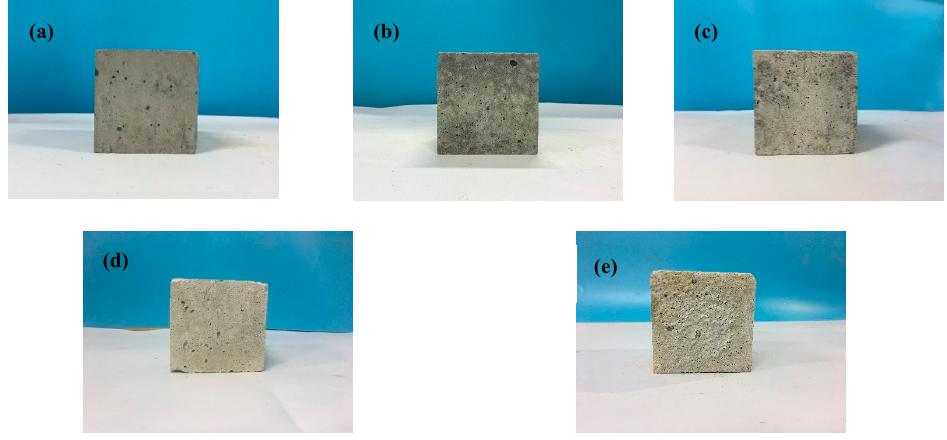
Figure 2. Appearance of C30 specimen at different sulfuration ages: ( a ) 0 days; ( b ) 2 days; ( c ) 5 days; ( d ) 10 days; and ( e ) 20 days.